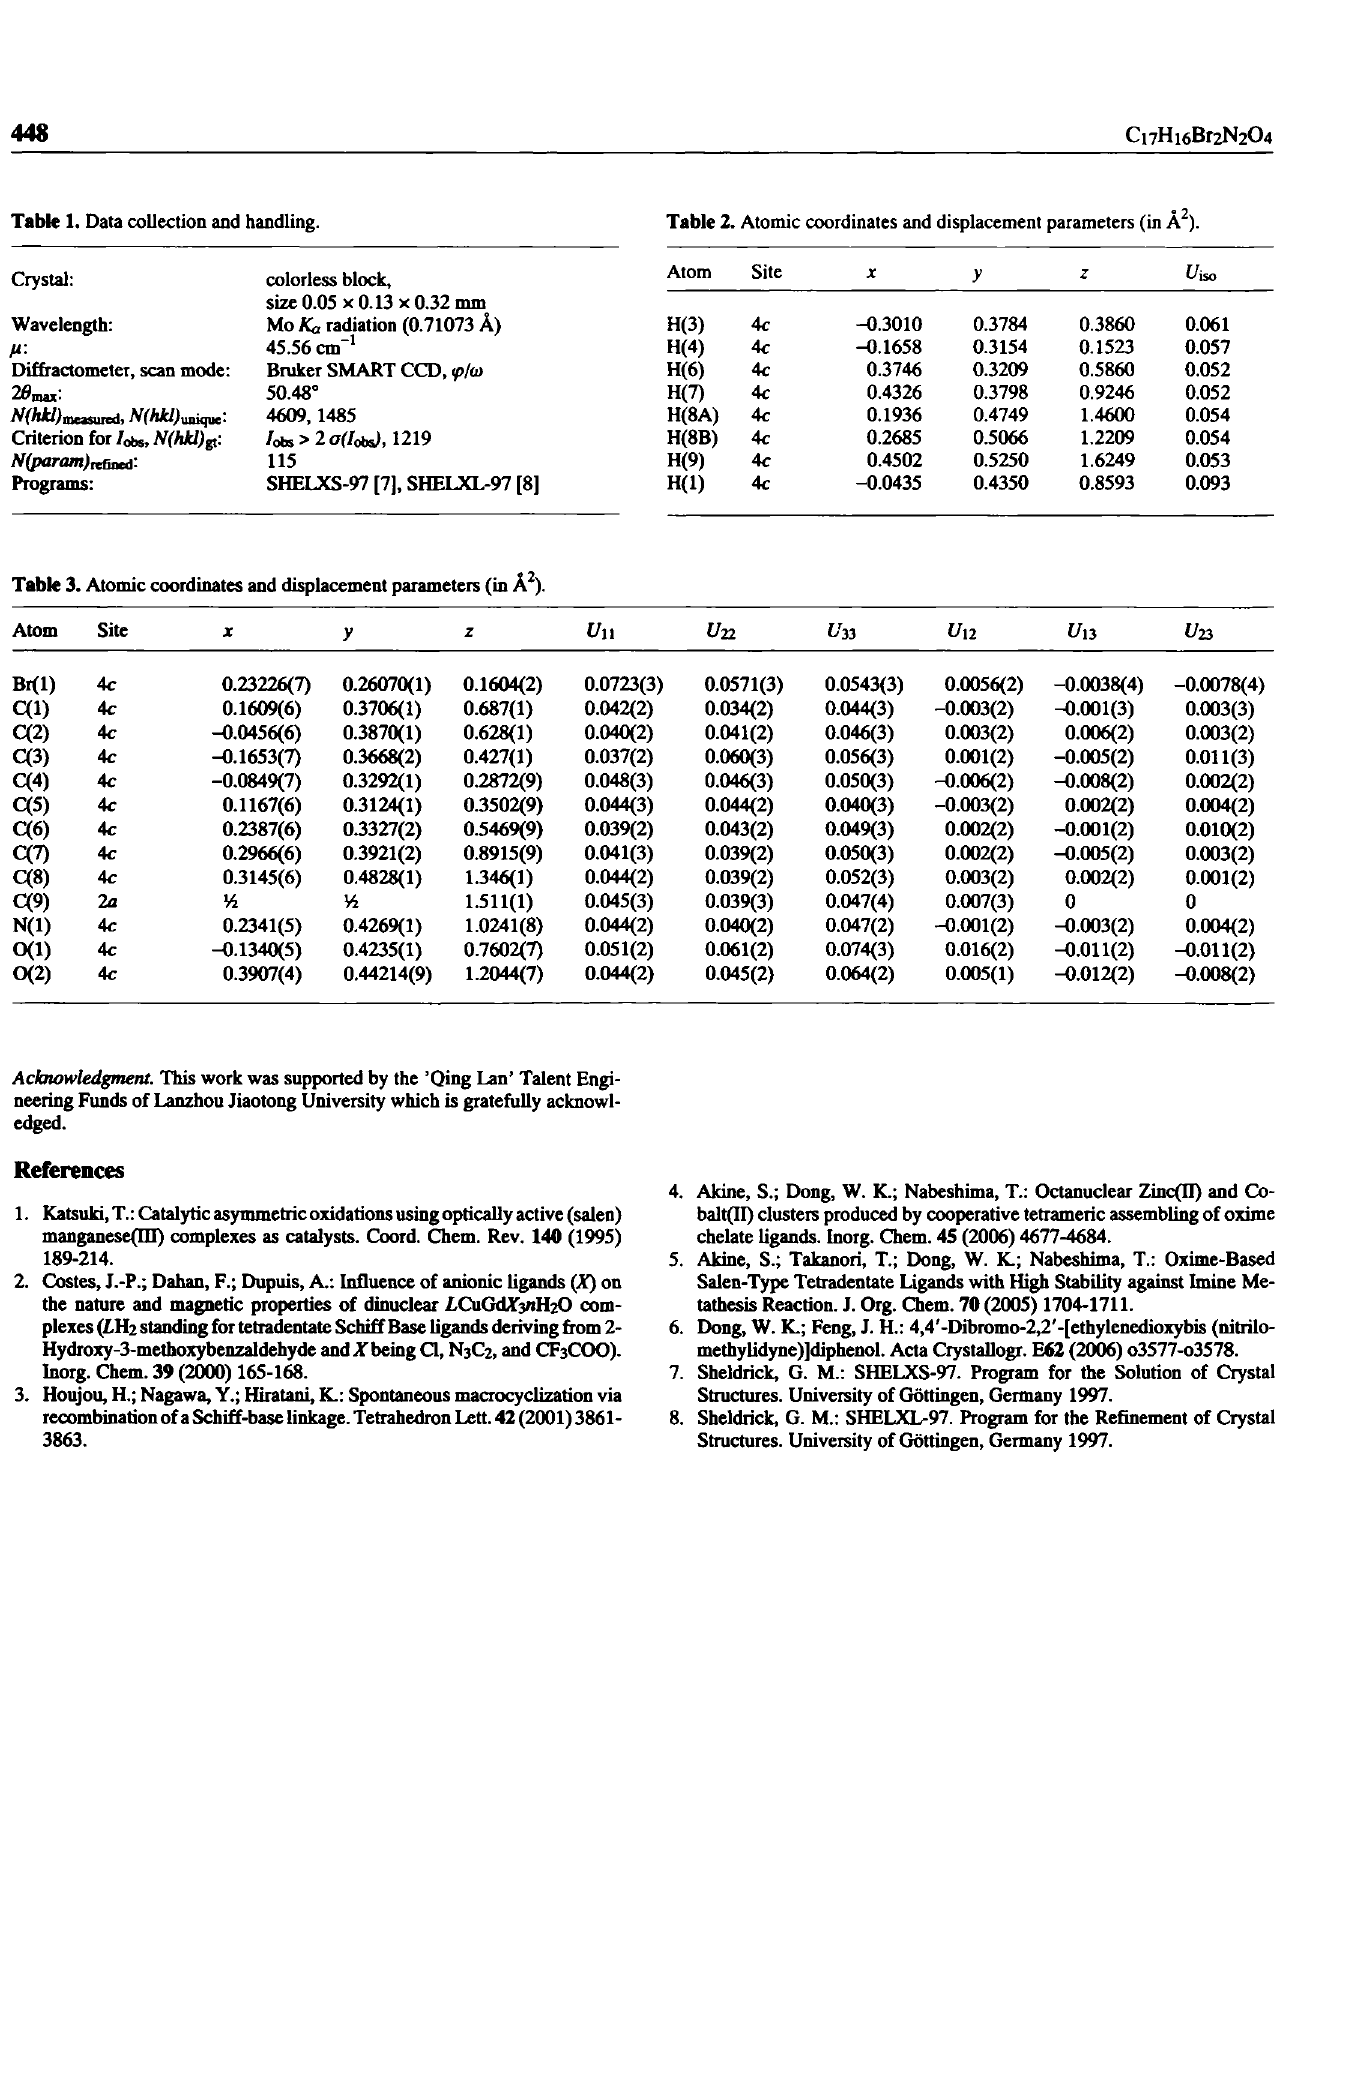
Table 3. Atomic coordinates and displacement parameters (in A 2